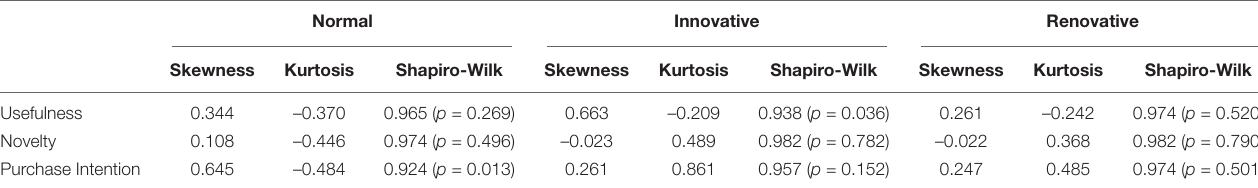
TABLE 5 | In Experiment 2, the measurements of kurtosis and skewness as well as the W -test on the dependent variables (the differences in the evaluation scores between pre-test and post-test, (cid:52) M = M post − M pre ).